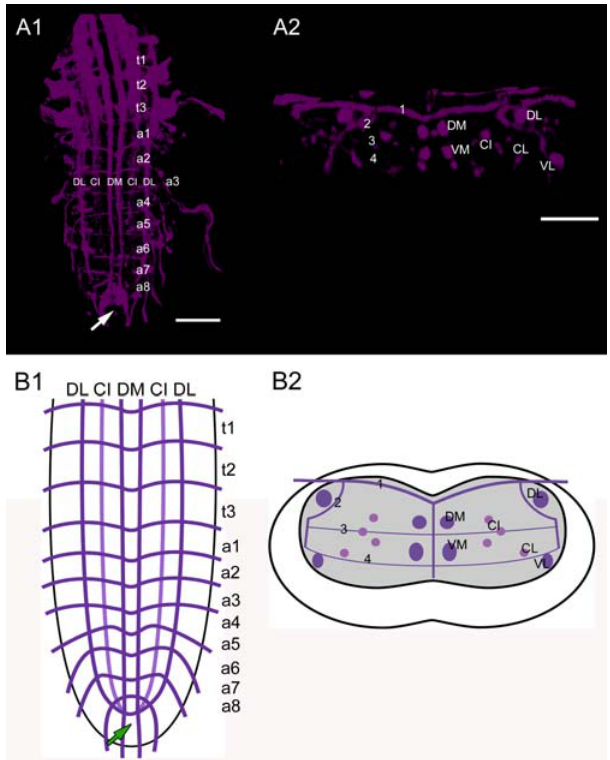
Figure 1. Fasciclin2 labeling. The Fas2 landmark system. A1) Dorsal view of a maximal projection showing longitudinal and transverse Fas2 immunoreactive fascicles. A2) Transversal view at the height of neuromere a3. B1) Idealized dorsal scheme B2) Idealized transverse scheme. Arrows in A1 and B1 show the neuromere a9 (‘‘terminal plexus’’). Scale bars: 50 m m in A) , 25 m m in B) .